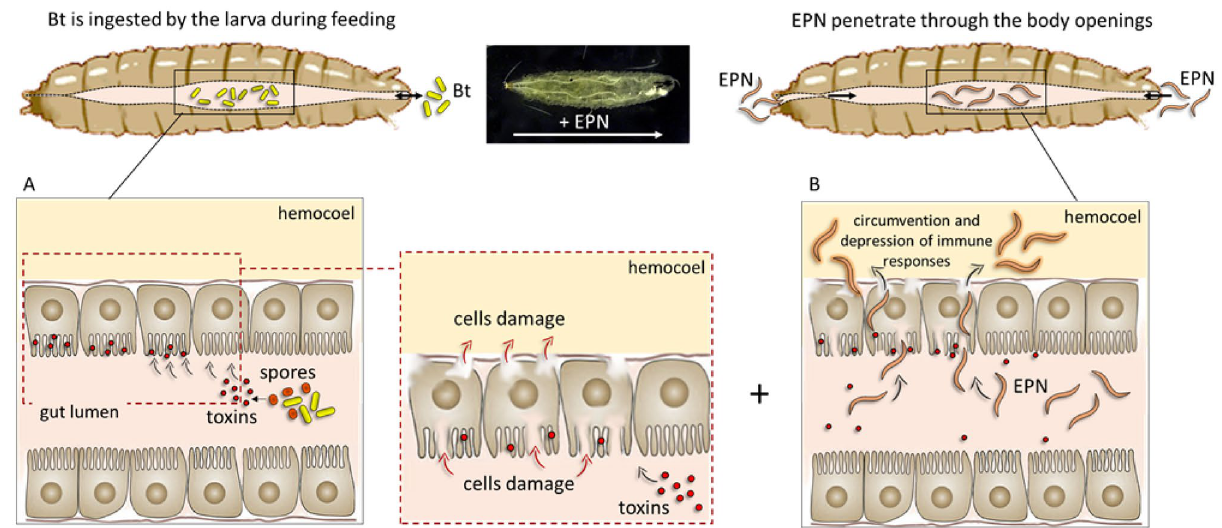
Figure 9. A possible model of the effects induced by the combined administration of B. thuringiensis (Bt) and S. carpocapsae (EPN) to D. suzukii larvae. The presence of B. thuringiensis , ingested during feeding by D. suzukii larvae, could facilitate and speed up the passage of S. carpocapsae from the intestine to the hemocoelic cavity. Bt toxins, produced as parasporal inclusions, are activated in the intestinal lumen of the larva. Active toxins interact with the membrane receptors of the intestinal epithelium and are responsible for the formation of pores that alter the physiology of the cells leading to their lysis. The resulting epithelial lesions could provide an easy access route for EPN to other body regions of the